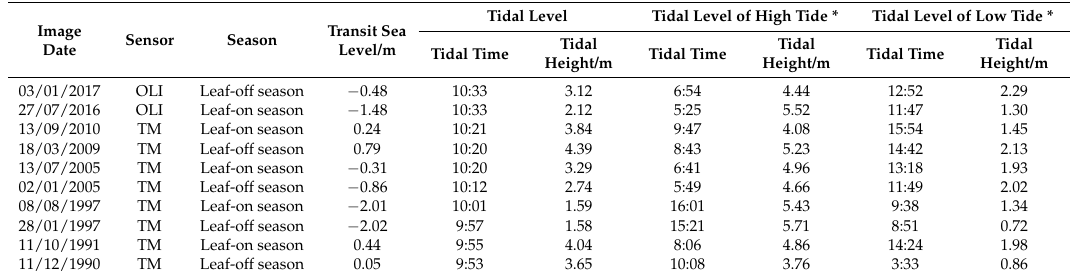
Table 1. Tidal information of selected satellite